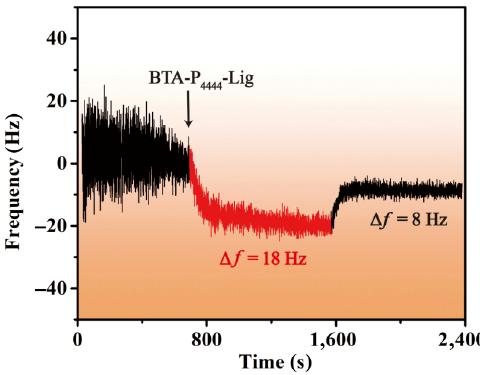
Fig. 12 Changes in frequency and corresponding dissipation of QCM chip gold (the solvent of ethanol is the baseline).